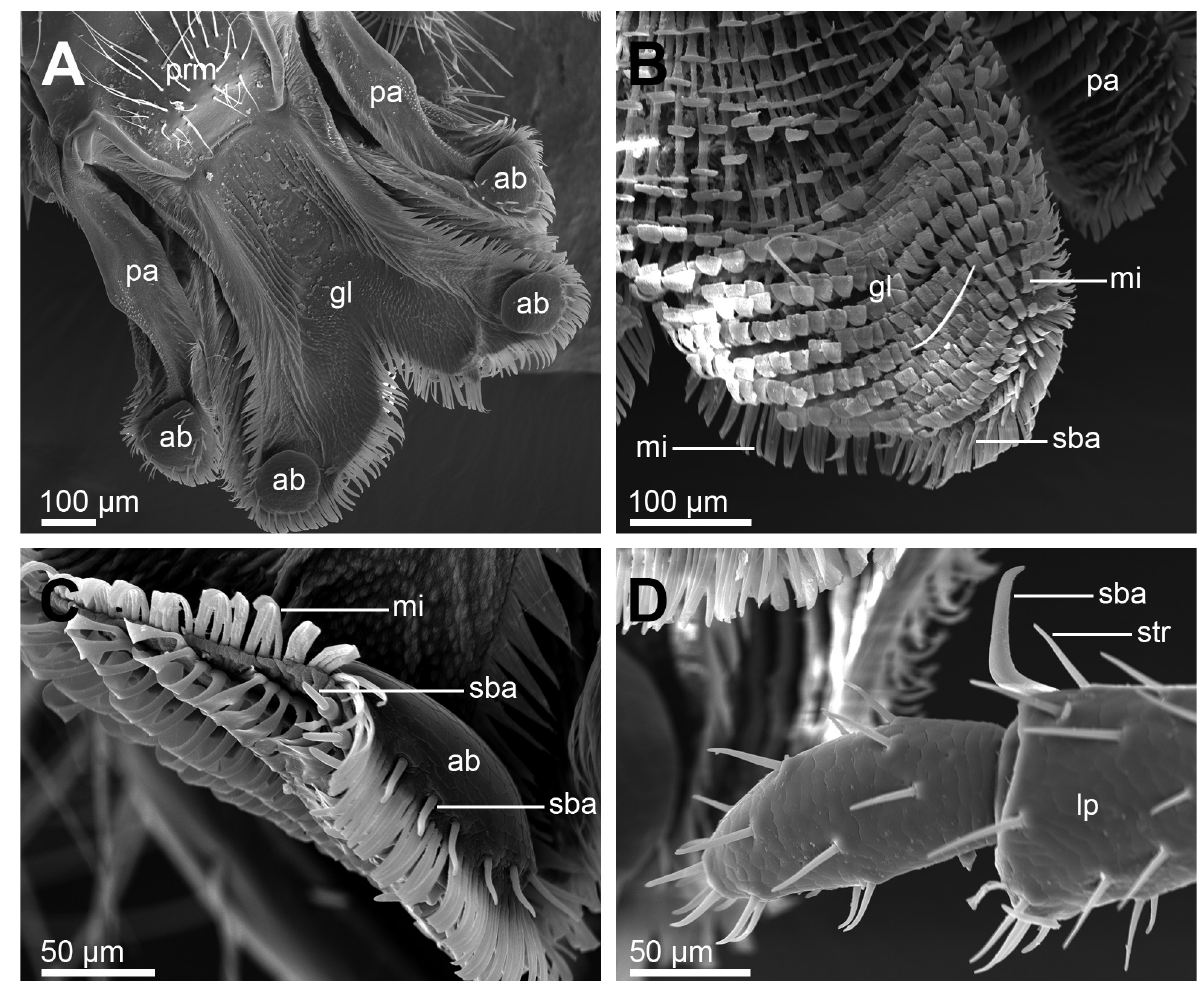
Figure 6. Labium (SEM). A. Extended ligula ( gl – glossa, pa – paraglossa) in posterior view, acrosomal buttons ( ab ) at the apex; prm – prementum. B. Apex of glossa ( gl ), spatula shaped microtrichia ( mi ) of the dorsal side; pa – paraglossa, sba – sensillum basiconicum. C. Distal edge of the paraglossa with rows of microtrichia ( mi ) and sensilla basiconica ( sba ); ab – acrosomal button. D. Third segment of labial palpus ( lp ), female with thorn-shaped sensillum basiconicum ( sba ) and sensilla trichodea ( str